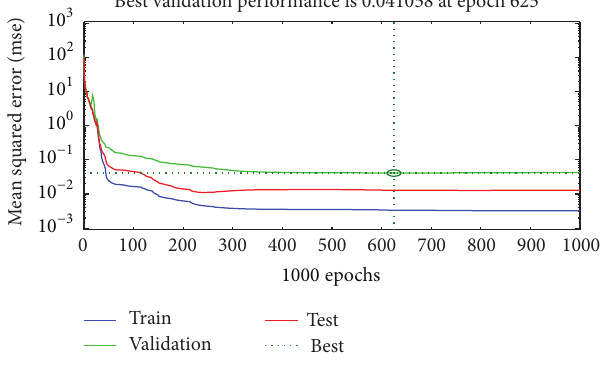
Figure 11: Performance graph of FFBP network.